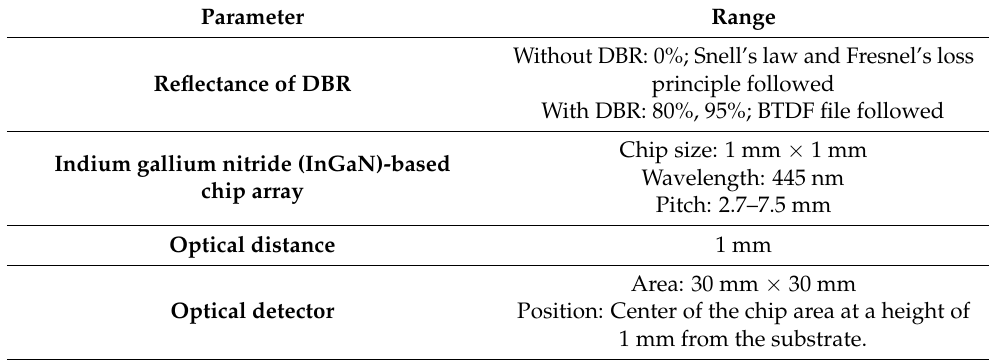
Table 1. Model parameters.